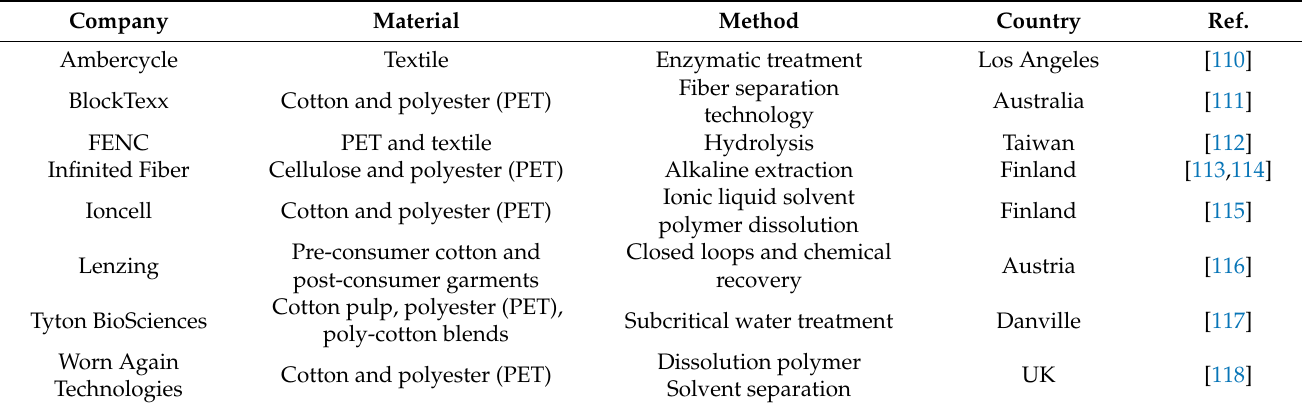
Table 2. Various chemical processes applied in textile recycling at the industrial